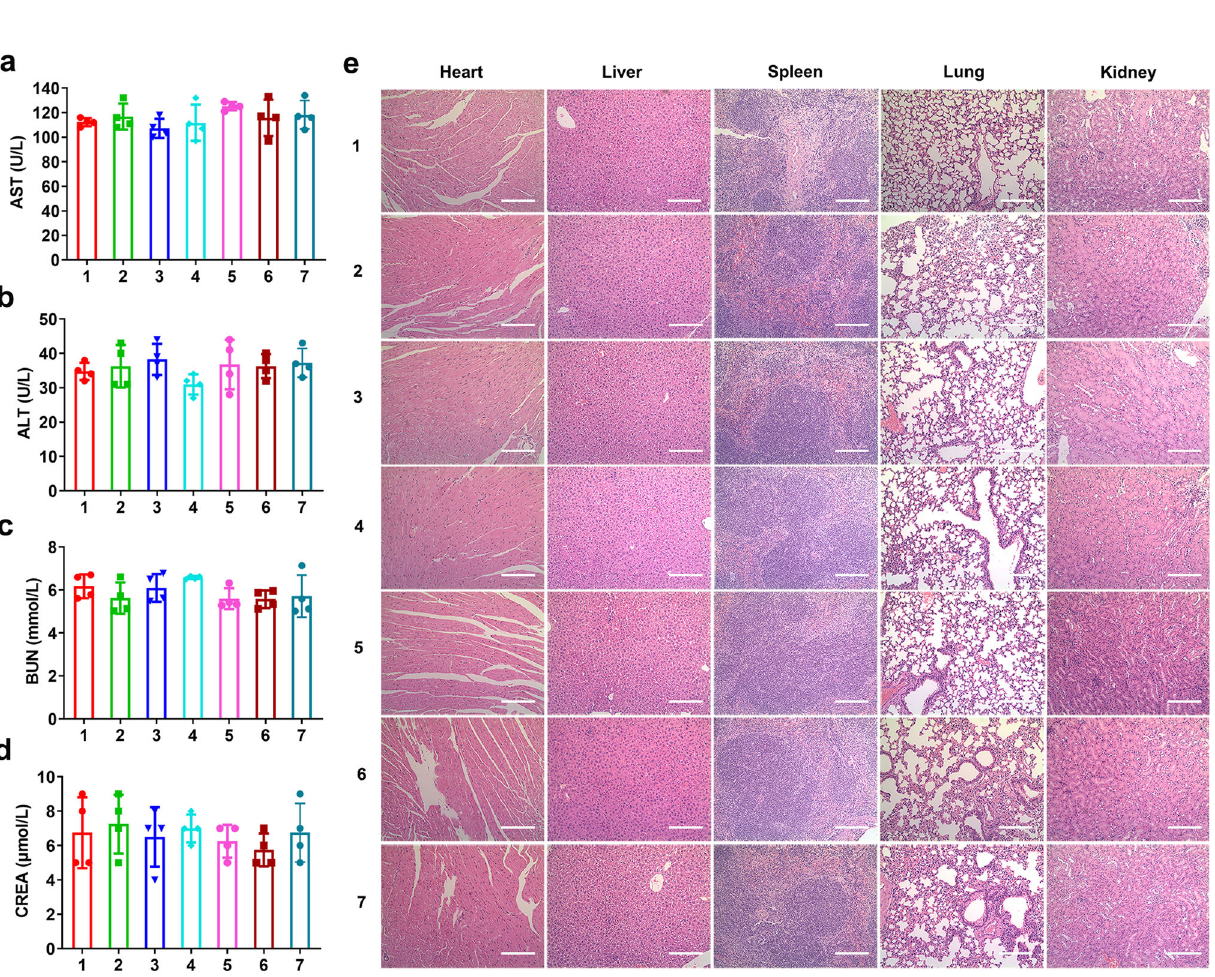
Fig. 10 Toxicity studies. Plasma levels of a AST, b ALT, c BUN, and d CREA after multi-dose injections of different drug formulations (1: PBS; 2: free Oxa; 3: Oxa(IV)@ZnPc; 4: Oxa(IV)@ZnPc@M; 5: BMMs; 6: Oxa(IV)@ZnPc@M + anti-PD-L1; and 7: BMMs + anti-PD-L1) ( n = 4 individual animals). No signi fi cant difference of the treatment group compared with PBS group. e H&E staining of major organs after multi-dose injections, this experiment was performed two times with similar results. Scale bars = 200 µ m. All data were presented as mean ± SD. Source data are provided as a Source data fi